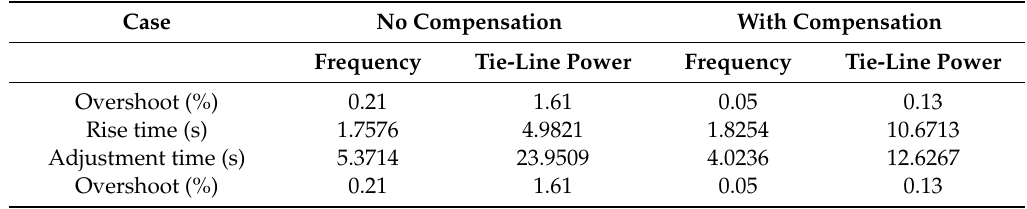
Table 4. Simulation results with LFC strategy.